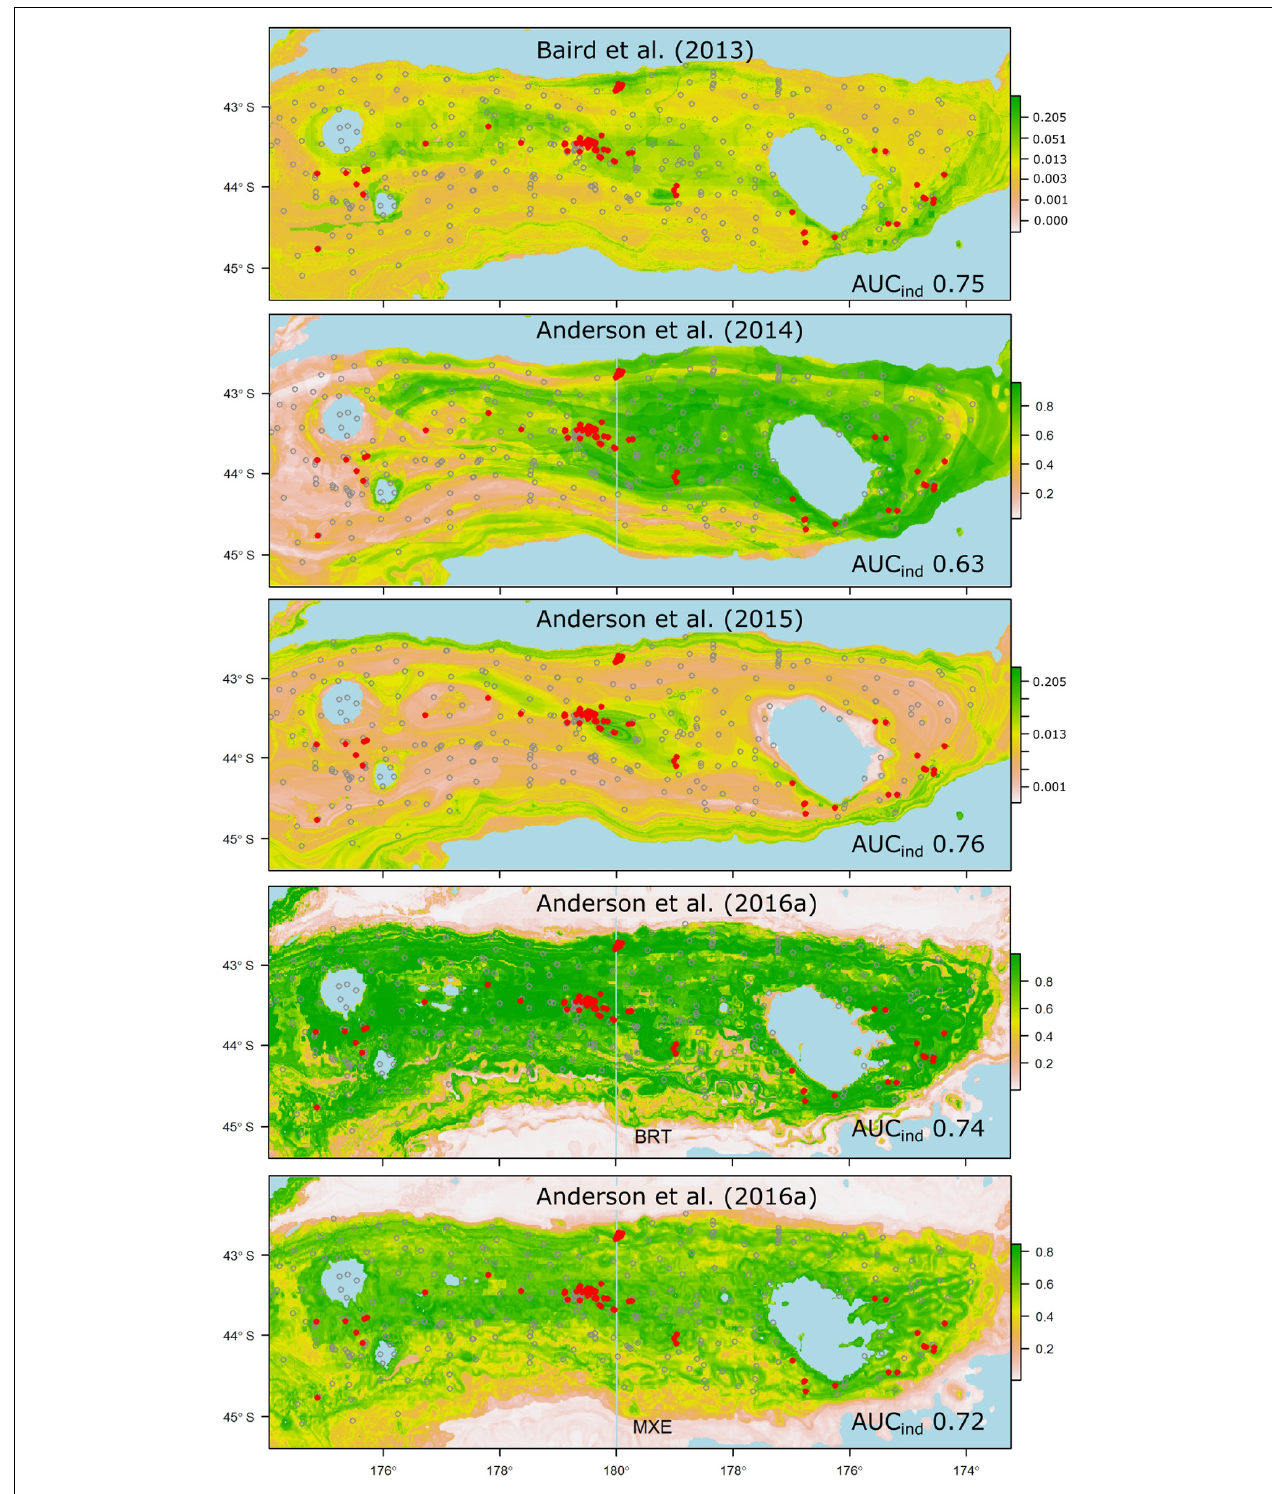
FIGURE 6 | Probability of suitable habitat for all thicket- or reef-building Scleractinian corals ( Solenosmilia variabilis , Madrepora oculata , Enallopsammia rostrata , and Goniocorella dumosa ) on Chatham Rise, as predicted by habitat-suitability models in four published studies. Anderson et al. (2016a) produced two models for reef-building corals, one using BRT, the other MaxEnt (MXE). Probability values are scaled at right, and prediction maps are overlaid with presence (red dots) and absence (gray circles) locations from the independent photographic observation dataset.